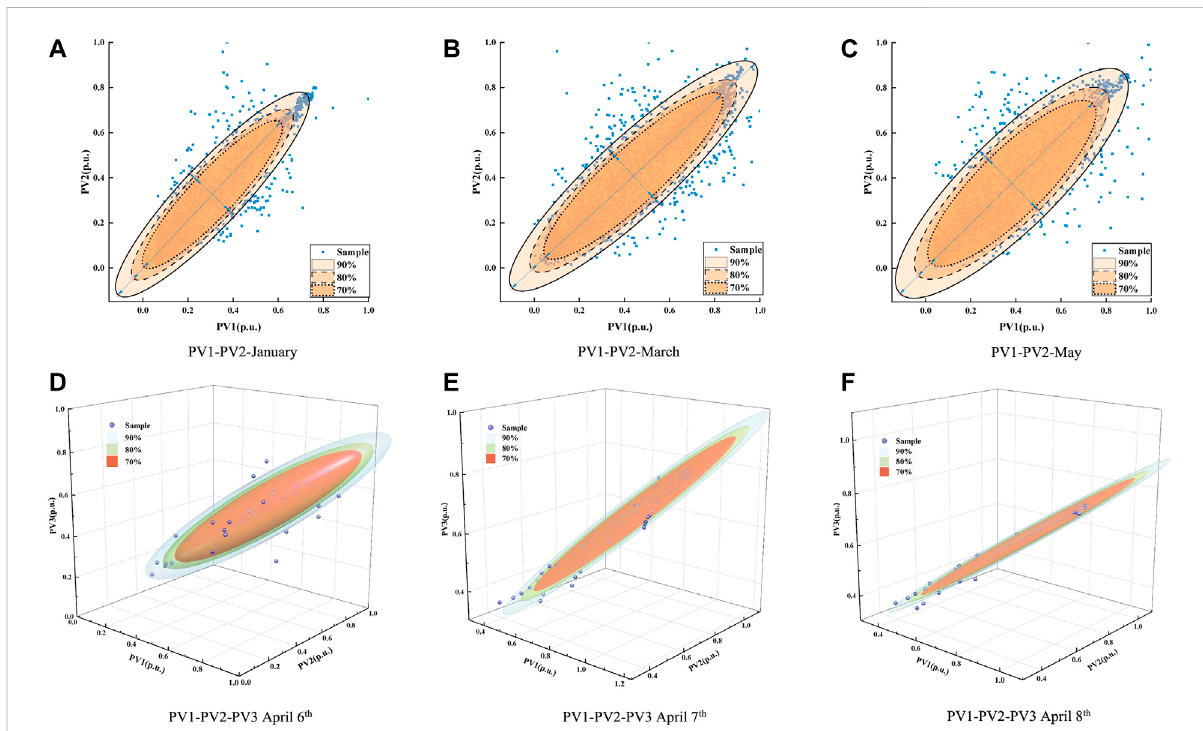
FIGURE 2 Power distribution and con fi dence interval of PV1-PV2 and PV1-PV2-PV3 at partial time. (A) PV1-PV2-January, (B) PV1-PV2-March, (C) PV1- PV2-May, (D) PV1-PV2-PV3 April 6th, (E) PV1-PV2-PV3 April 7th, and (F) PV1-PV2-PV3 April